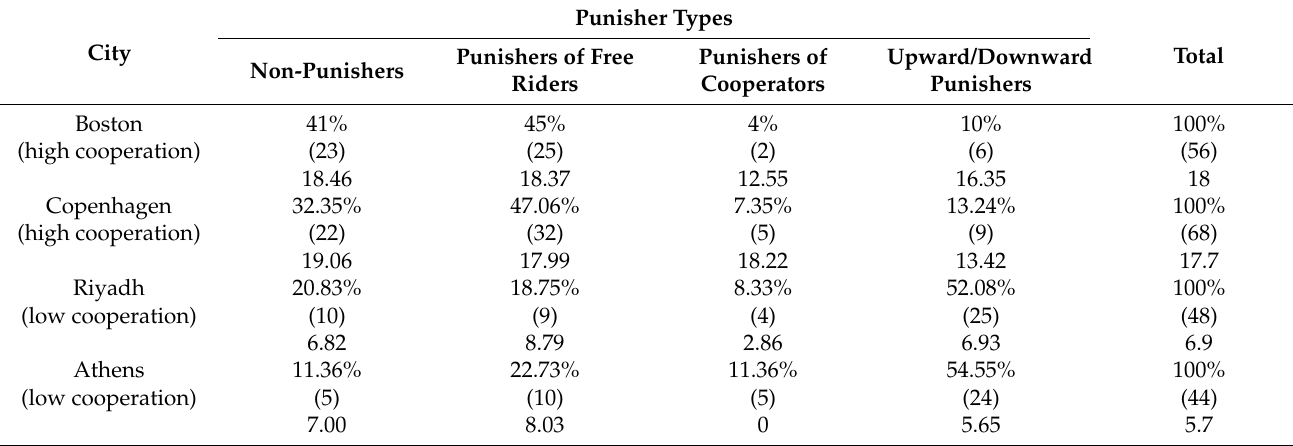
Table 3. Relative frequencies of punisher types in participant pools from representative cities with high and low cooperation (data source: Hermann et al., Science,